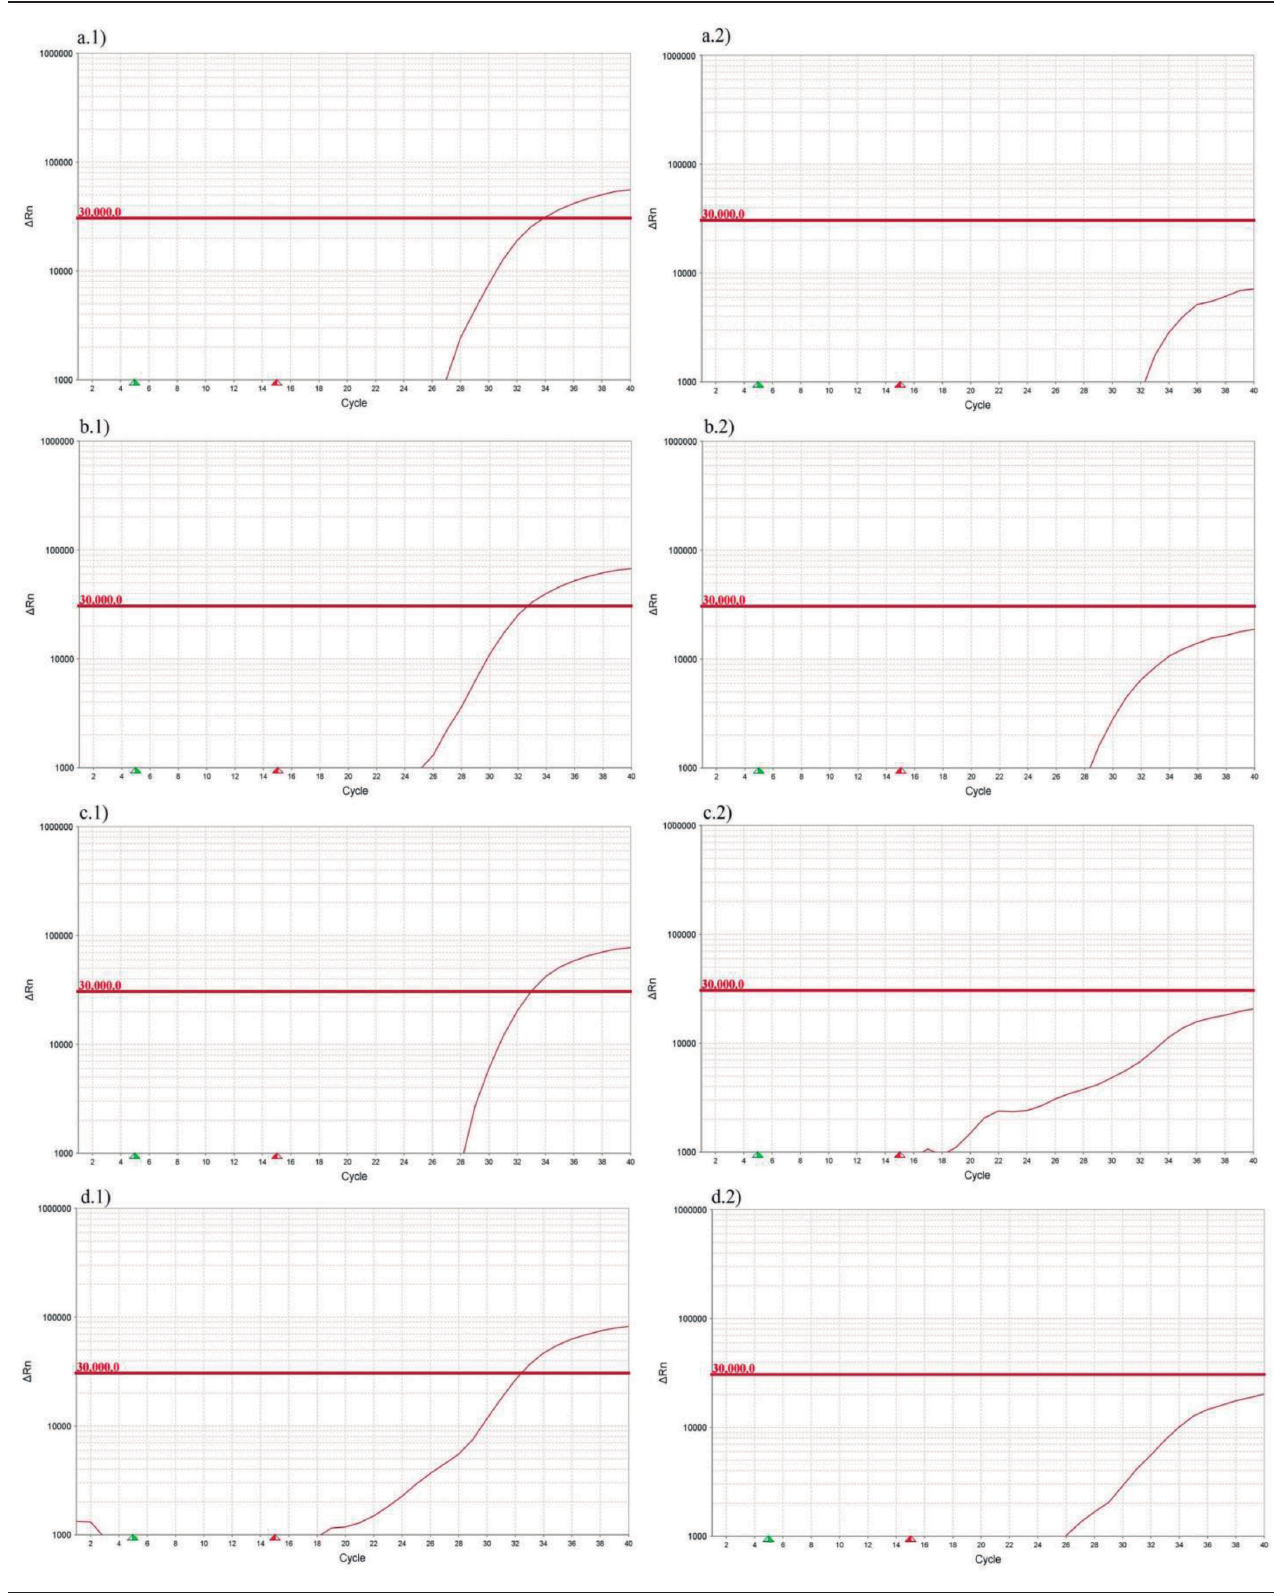
FIGURE 1 – Amplification of ORF1ab from samples 25 (a), 26 (b), 39 (c) and 40 (d) before (.1) and after (.2)